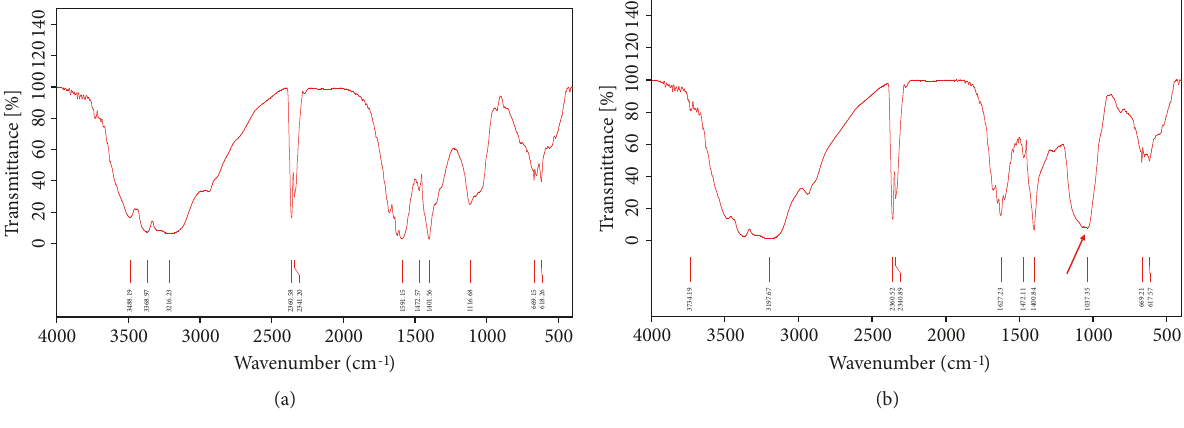
Figure 3: The infrared spectra of AMP (a) and sAMP 6